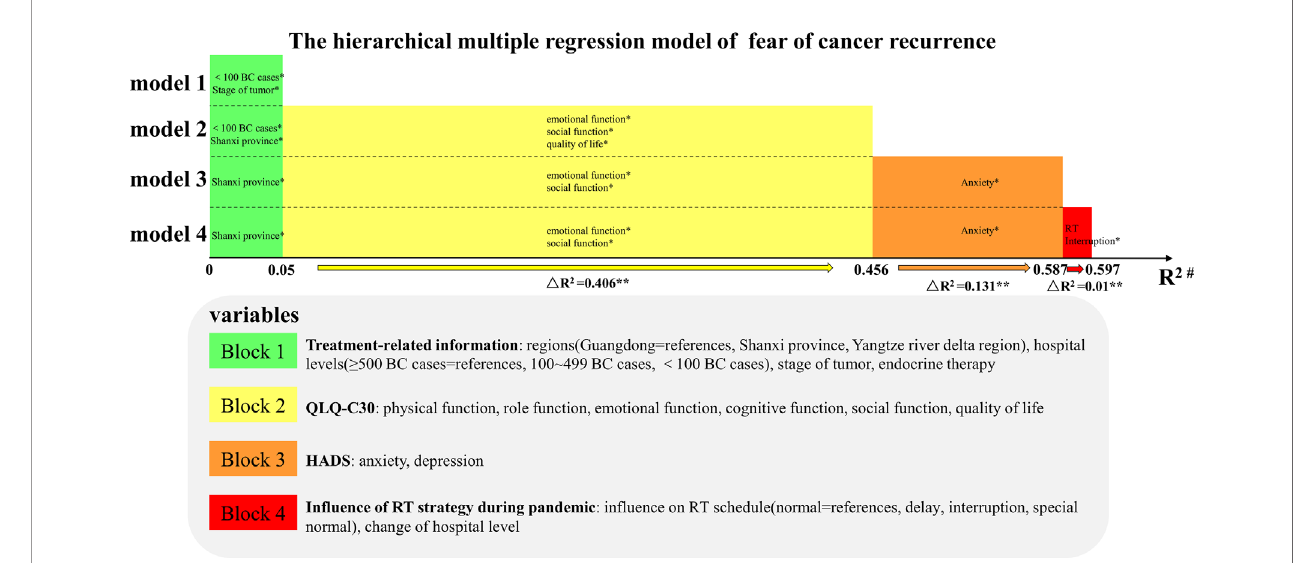
FIGURE 2 | The hierarchical multiple regression model of fear of cancer recurrence. Candidate variables with P < 0.2 in ANOVA, t-test or Pearson correlation analyses were de fi ned as explanatory variables and divided into four Block in the model: treatment-related information, functional scales and global QoL in QLQ-C30, anxiety and depression score according to HADS questionnaire, in fl uence of RT strategy during pandemic. New variables in the corresponding Block will be added to the model in each step to explore the effect of adding variables to FCR. In Block 4, in fl uence of RT schedule and change of hospital levels were included. The fi nal model showed that an additional 1% of the variances in FCR was observed and changes of the model remained signi fi cant ( △ R2 = 0.01, △ F=2.966, p=0.019). Finally, hierarchical multiple regression model explained 59.7% of the observed variances in FCR and in fl uence of RT strategy during pandemic had signi fi cantly impact on FCR ( △ R2 = 0.01, △ F=2.966, p=0.019). *variables of p < 0.05 in models; **p < 0.05 for changes of models; # coef fi cient of determination for corresponding step. BC, breast cancer; RT,